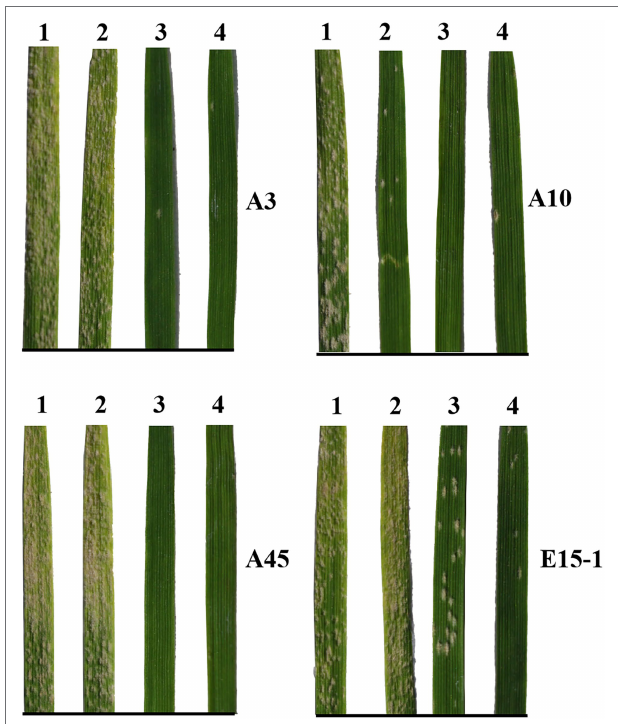
FIGURE 3 | Reaction patterns of several Pm2 donors to four Blumeria graminis f. sp. tritici ( Bgt ) isolates, A3, A10, A45, and E15-1, collected from different regions of China using Huixianhong as susceptible control. 1: Huixianhong; 2: Lande 677; 3: Shimai 24; and 4: